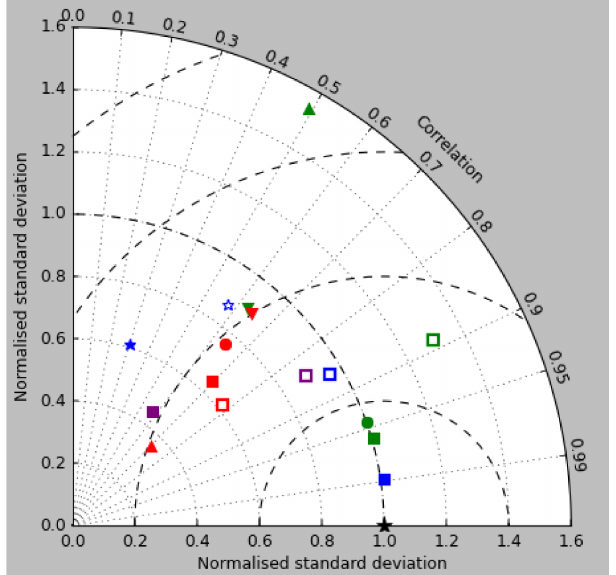
Figure 29. Taylor diagram of nitrate (green), silicate (red), oxygen (blue) and apparent oxygen utilisation (purple); model values are averaged over the years 2010 to 2019, and observations are from the 2013 World Ocean Atlas. Filled squares show the surface concen- trations, open squares the concentrations at the nearest depth level to 1050m, and circles, upward-pointing triangles and downward tri- angles respectively show the midpoint, amplitude and phase of the sine curve that best fits the seasonal cycle (only at points for which the residual variance is less than half the original). The filled and open stars respectively show the vertical extent of the water column where the O 2 concentration is below 50 and 100mMolO 2 m − 3